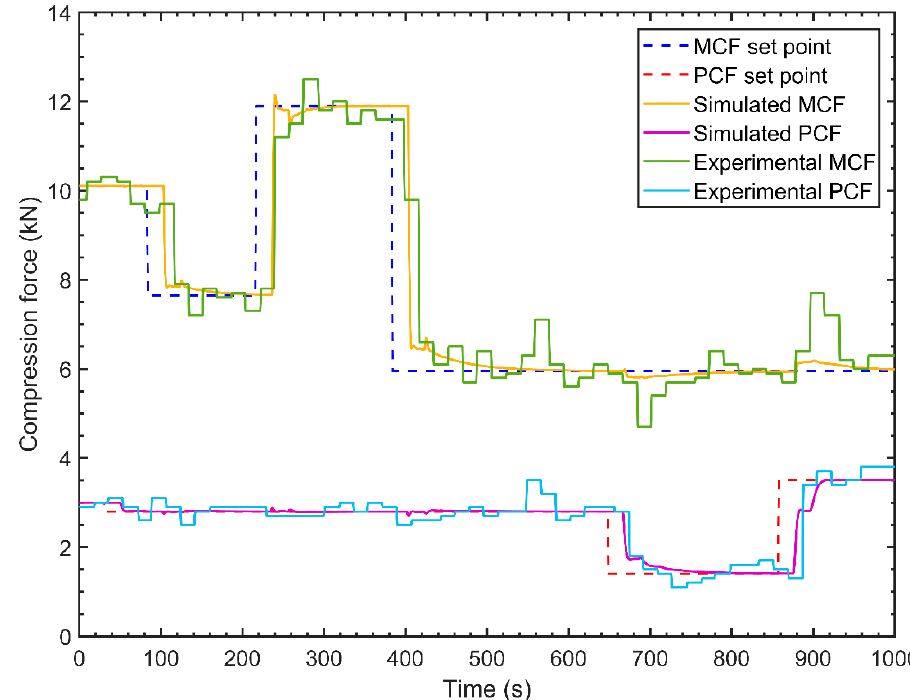
Figure 13. Control strategy 1—Experimental validation.